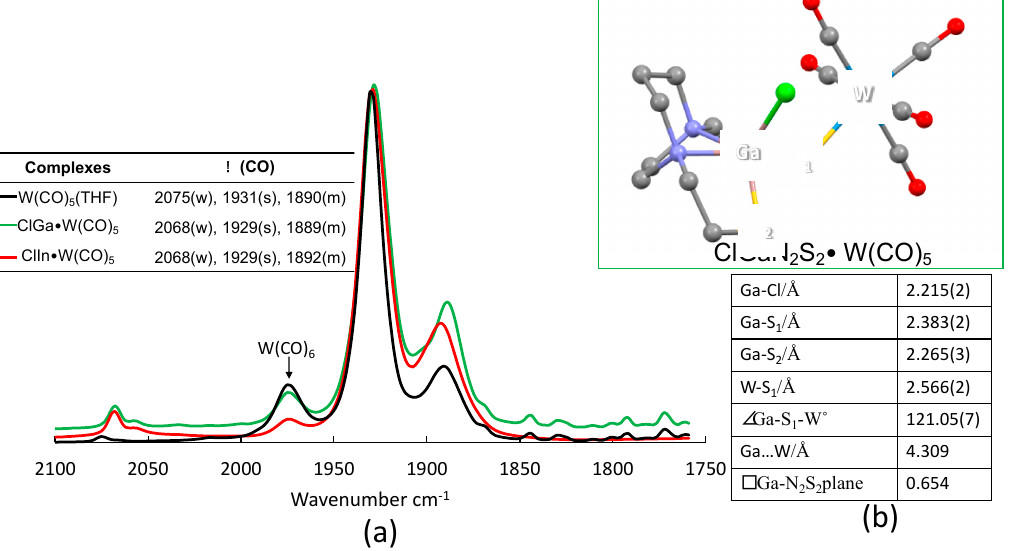
Figure 6. ( a ) IR spectra in ν (CO) region of products from reactions of W(CO) 5 (THF) with XMN 2 S 2 ; ( b ) XRD determined molecular structure of ClGaN 2 S 2 ·W(CO) 5 with selected metric data. Orange sheet crystals of ClGaN 2 S 2 · W(CO) 5 were obtained from THF solution by hexane